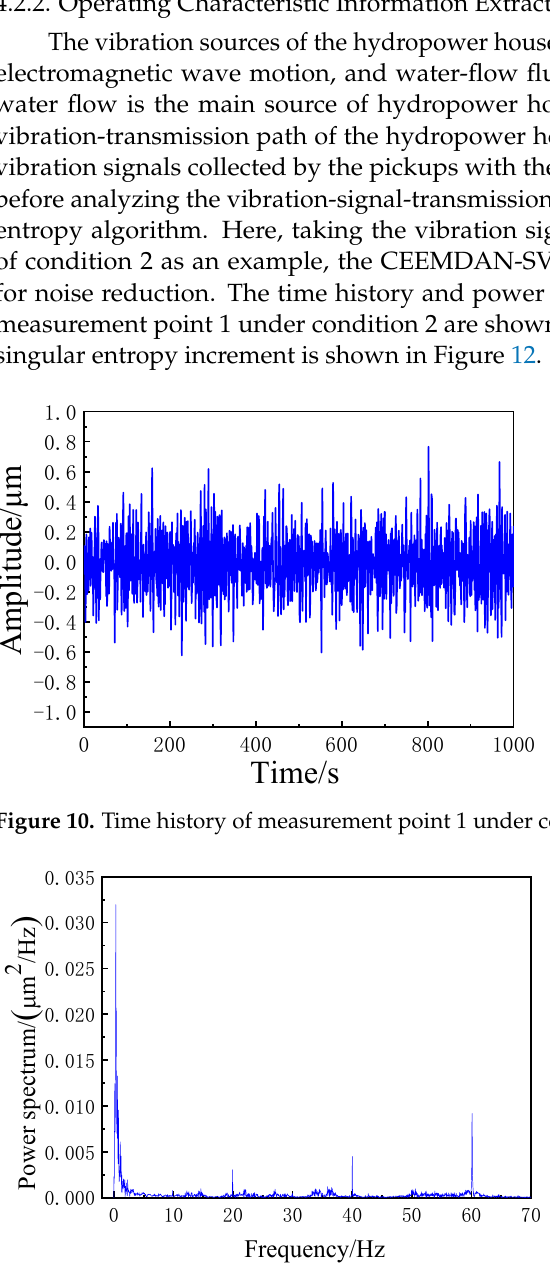
Order Figure 12. Singular entropy-increment curve. From the power spectrum in Figure 11, the vibration response of measurement point 1 has four main frequency bands, 60 Hz, 40 Hz, 20 Hz and 0.5 Hz. The singular entropy increment curve is shown in Figure 12. According to the theory of singular entropy incre- ment, the value of the singular entropy increment after the 70th order tends to be stable and is less than 0.03, which means that the singular value before 70th order already con- tains the main characteristic information of vibration signal, and the singular value after 70th order is mostly caused by noise. Therefore, the optimal singular value order r is defined as 70. The vibration response of measurement point 1 under condition 2 is processed by CEEMDAN-SVD and four IMFs are obtained; the IMFs are shown in Figure 13. The fre- quencies of IMF1-IMF4 correspond to the bands in Figure 11 (60 Hz, 40 Hz, 20 Hz, and 0.5 Hz), respectively. The vibration frequencies of 60 Hz, 40 Hz and 20 Hz correspond to the spike-power spectrum, and 0.5 Hz corresponds to the broad peak-power spectrum. The broad peak-power spectrum is the typical feature of a low-frequency water-flow signal; the vibration excitation band of 0.5 Hz corresponds to the water-flow fluctuation. The vi- bration of the hydropower house is mainly caused by water-flow fluctuation, so the IMF1 is retained as the required feature signal. With the help of CEEMDAN-SVD, the charac- teristic signal of water fluctuation is extracted from each measurement point and the vi- bration-transmission path of the hydropower house is analyzed on the basis of the water- fluctuation signal.